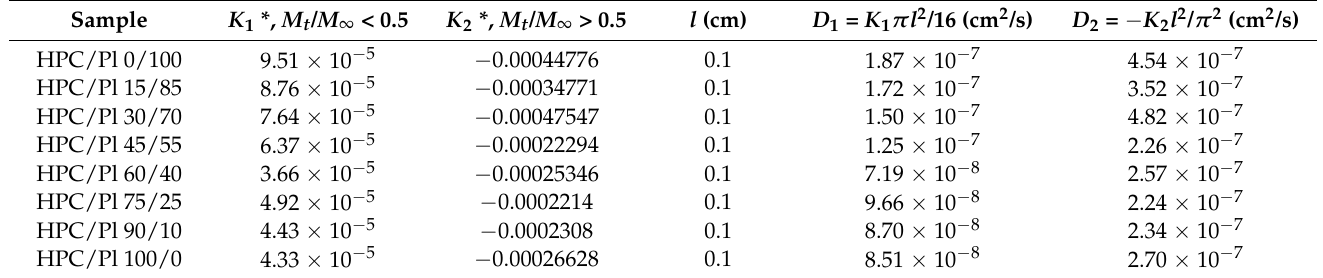
Table 2. Diffusion coefficients determined from experimental data for Pluronic and HPC mixtures.